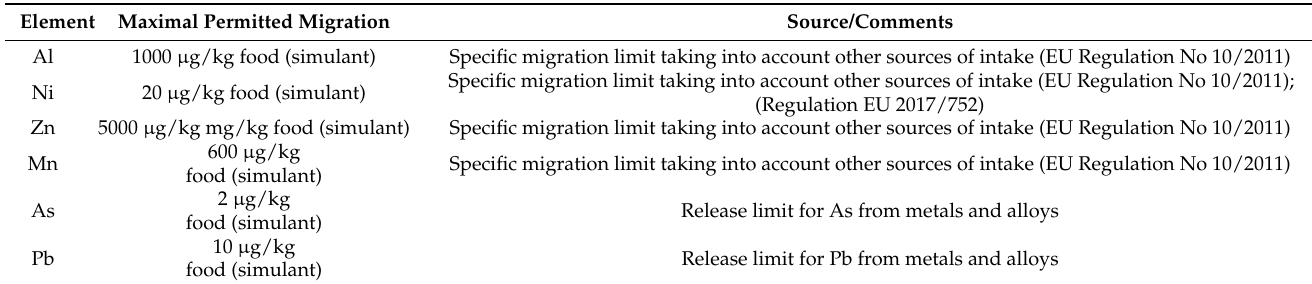
Table 5. Maximal permitted release limits for elements as stated in Regulation EU No 10/2011 and the Council of Europe guideline for metals and alloys used in food contact materials and articles.